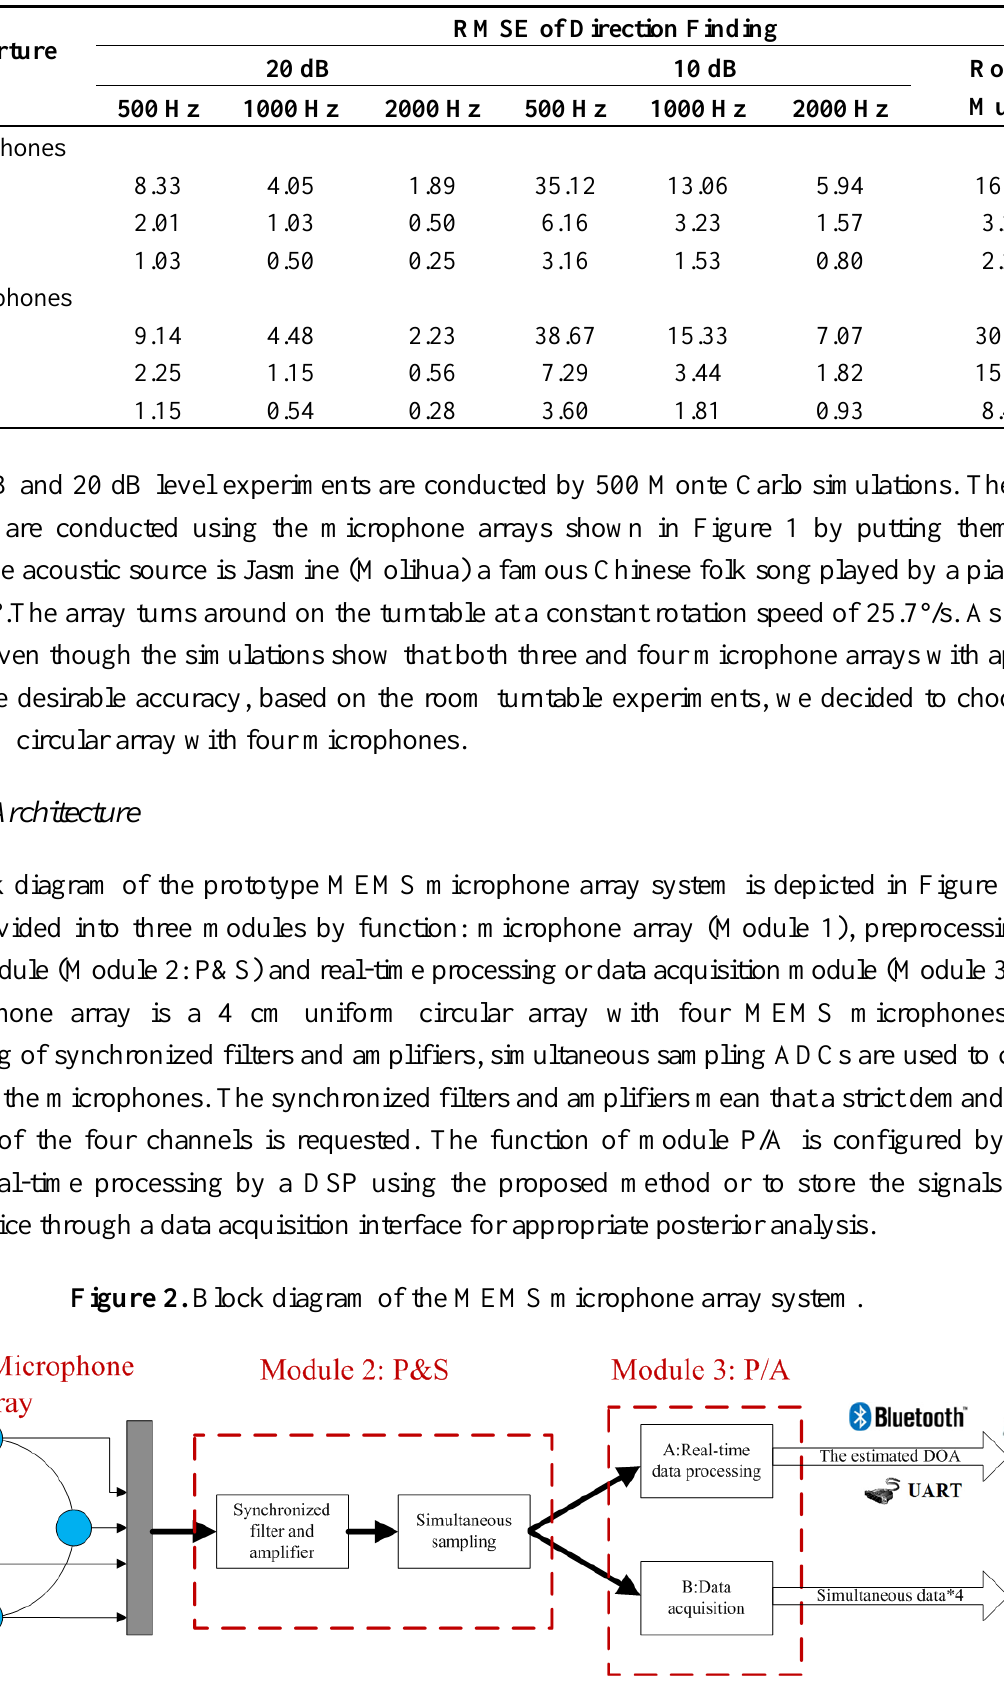
Table 1. The root-mean-square error (RMSE) of direction finding using MUSIC algorithm for different microphone arrays.